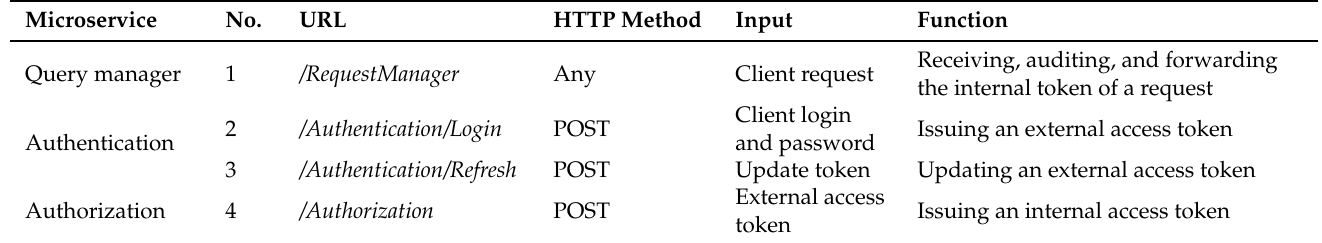
Table 2. Specification of query manager, authentication, authorization of the microservices’ API function.